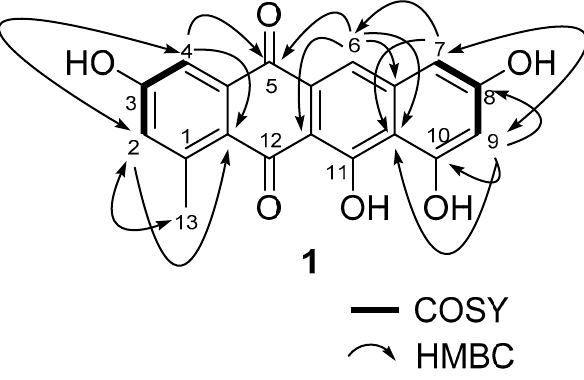
Figure 2. Key COSY and HMBC correlations for compound 1 .